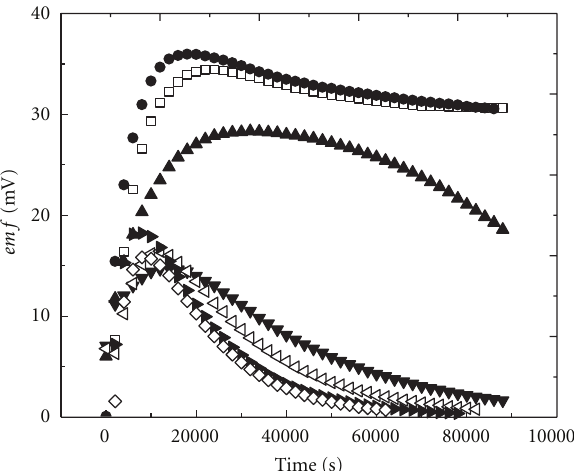
Figure 2: Concentration cell used to measure the electromotive force: (C) half cell, (E) electrodes, (M) ion-exchange membrane, and (S) magnetic stirrers.